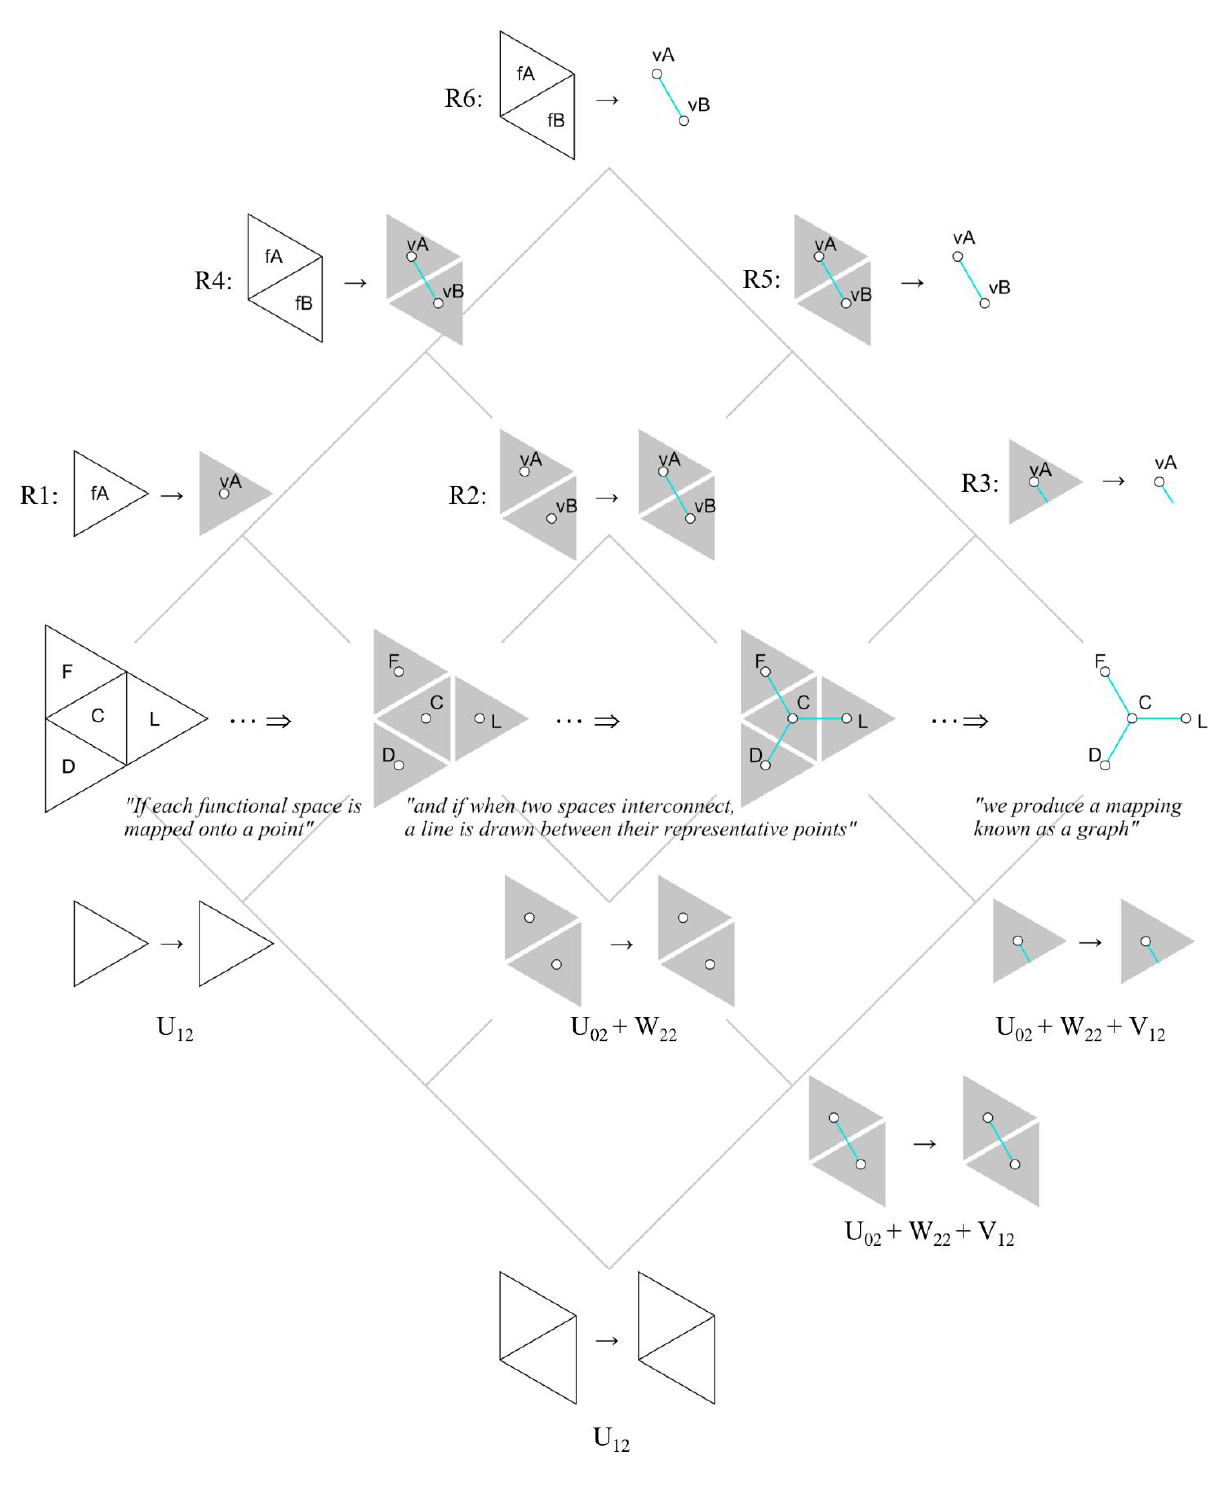
Figure 1. Shape rules induced from March and Steadman statements for the Sundt house plan. The initial shape represents the family (F), dining (D), and living room (L) zones, with the circulation (C) in between.